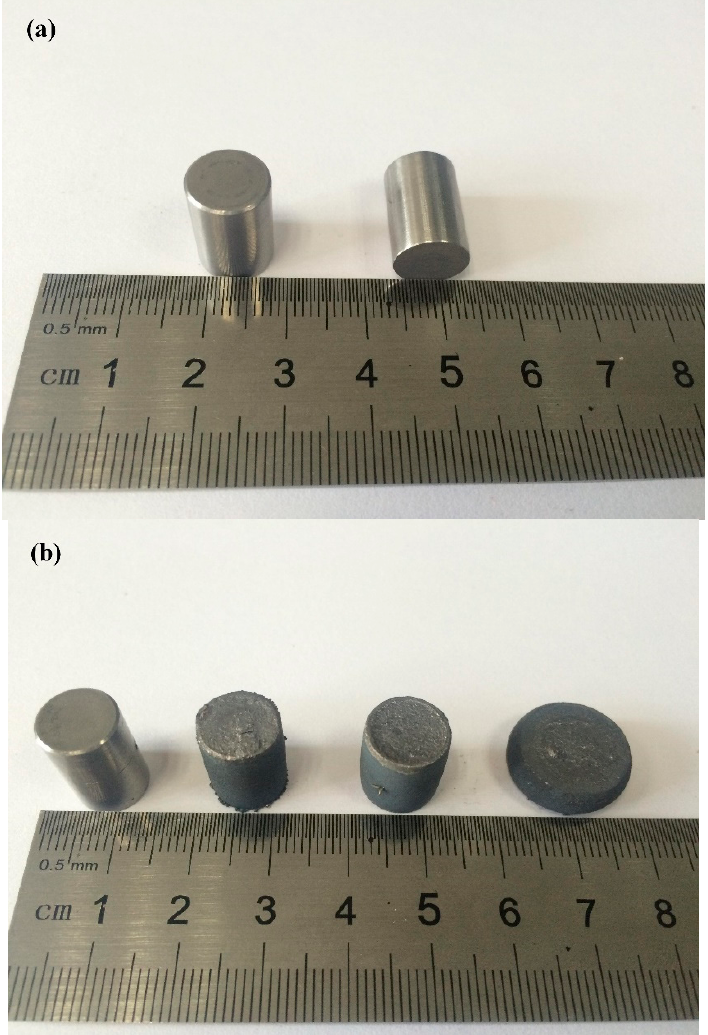
Figure 2. The appearance of the specimen: ( a ) before deformation and ( b ) after deformation.